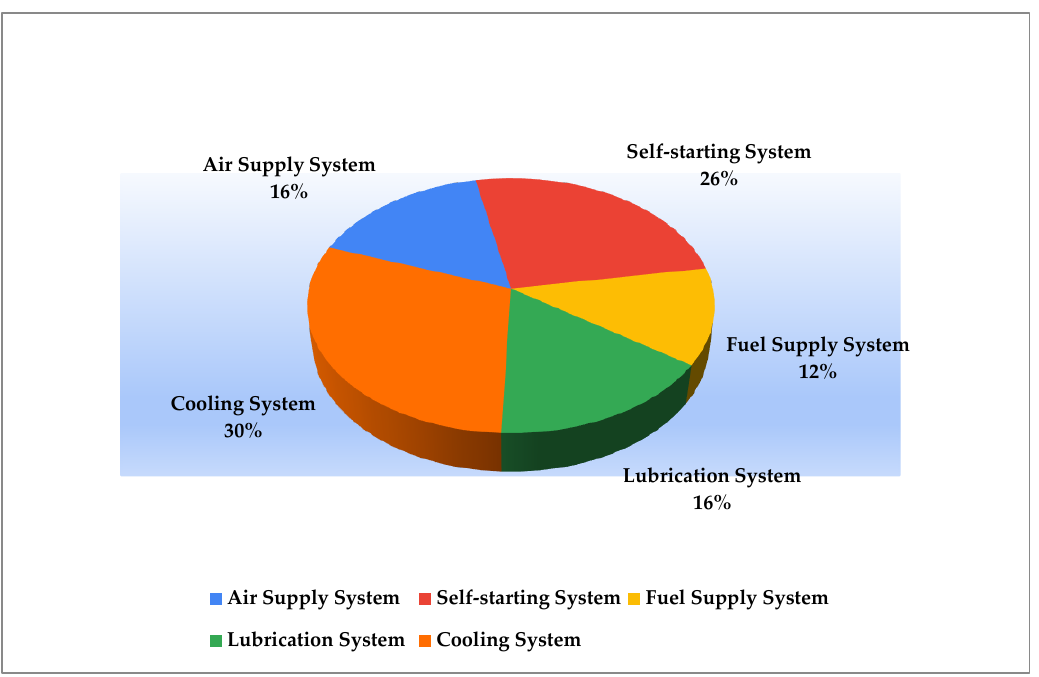
Figure 2. TBF Hours in percentage in comparison to total time for Engine 2.